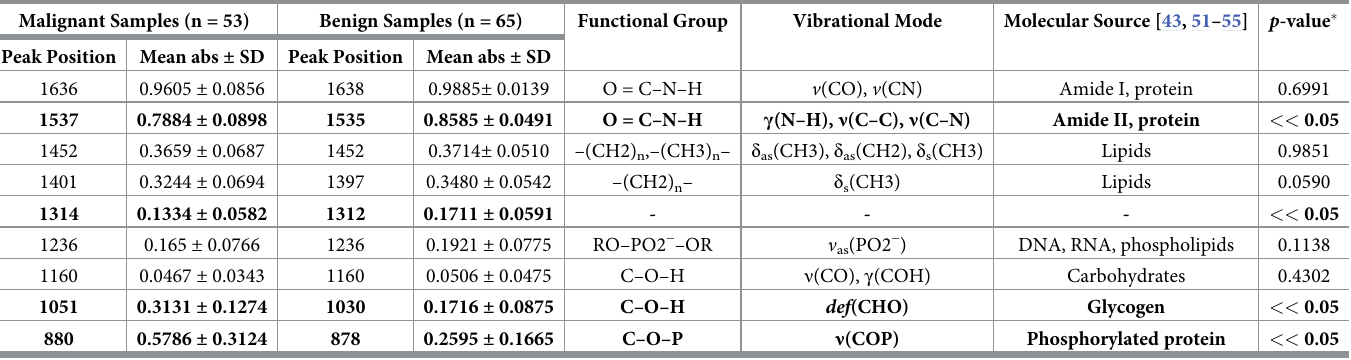
Table 3. Computation of the spectrum variables (peak positions and normalized absorbances) of malignant and benign lung samples in the fingerprint IR region (1800 cm -1 to 850 cm -1 ). Malignant Samples (n =